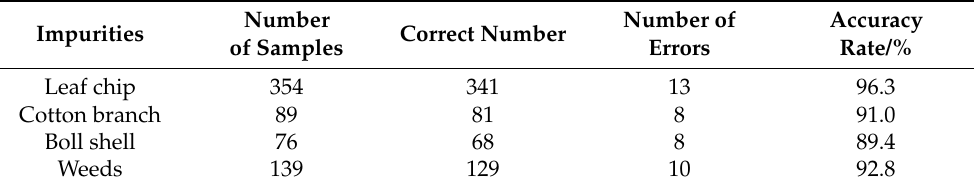
Figure 12. Classification and identification of impurities in machine-picked seed cotton. Table 3. Classification and recognition rates of impurities in seed cotton.